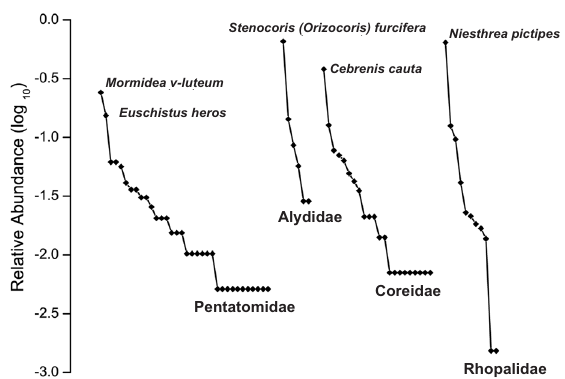
Figure 2 - Rarefaction curves showing species richness of each family studied in Parque Provincial Moconá in relation to its abundance.